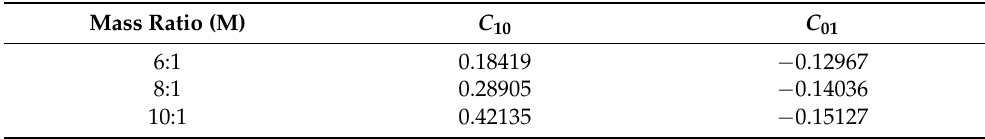
Table 1. Elastic coefficients of the silicone